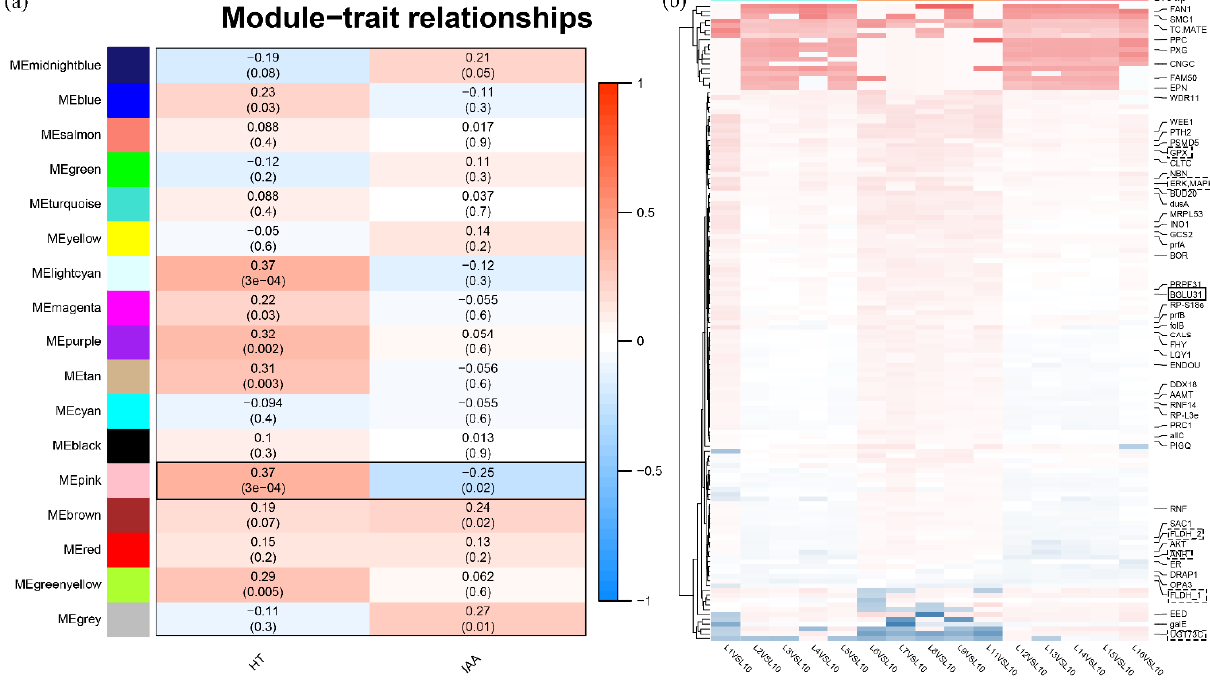
Figure 4. Expression analysis of DEGs in diverse bermudagrass across a latitude gradient. ( a ) Gene expression modules of WGCNA correlated with bermudagrass’s quantitative traits, including plant height (HT) and IAA content. We report the Pearson coefficient and its p -value. Highly positive correlations are shown in red, and highly negative correlations are shown in blue. The combination of module–trait marked in a black frame will be selected for subsequent expression and annotation analysis. ( b ) Transcript-level difference of module genes in bermudagrass from different latitudes measured by comparisons of Log2 (sample from different latitude counts/L10 sample counts).